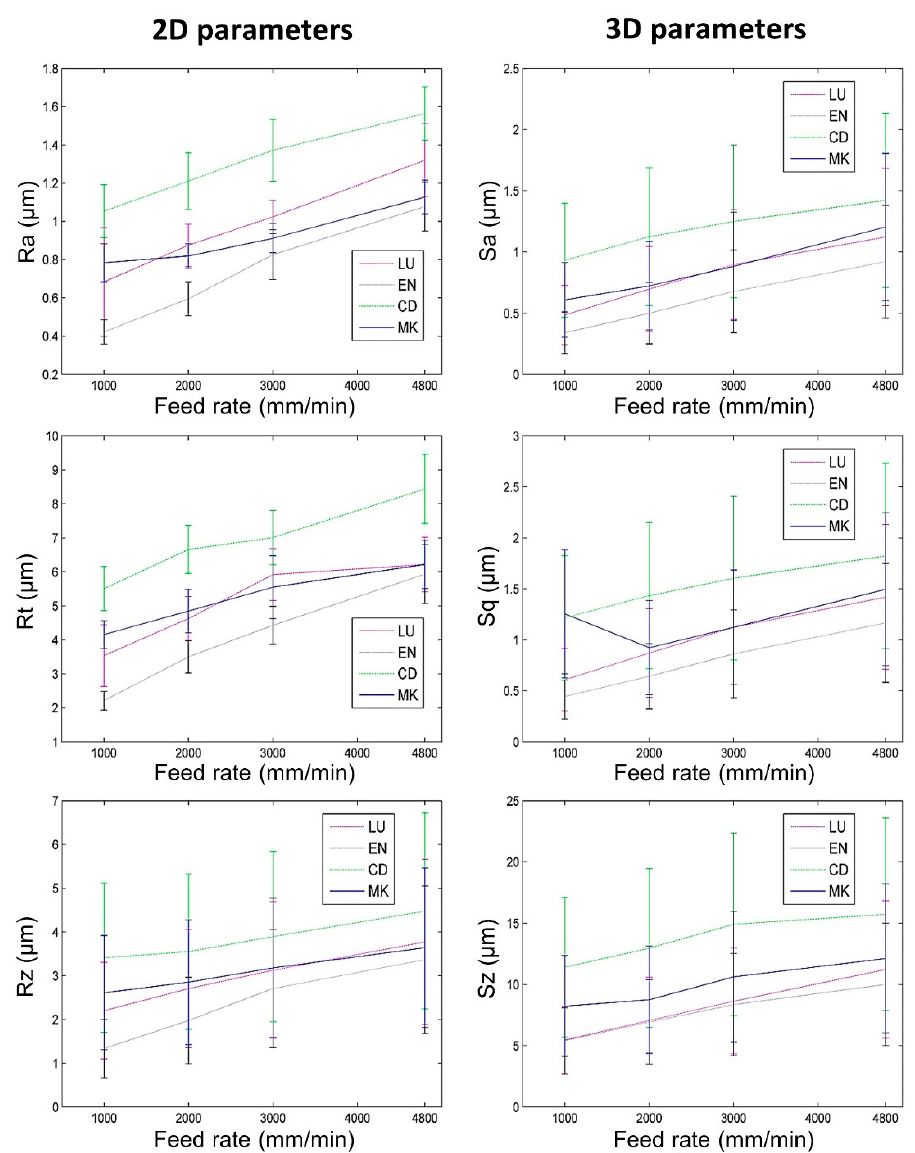
Figure 6. Roughness depending on prosthetic material and feed rate when milling with the Cerec tool (vertical bars represent standard deviation).